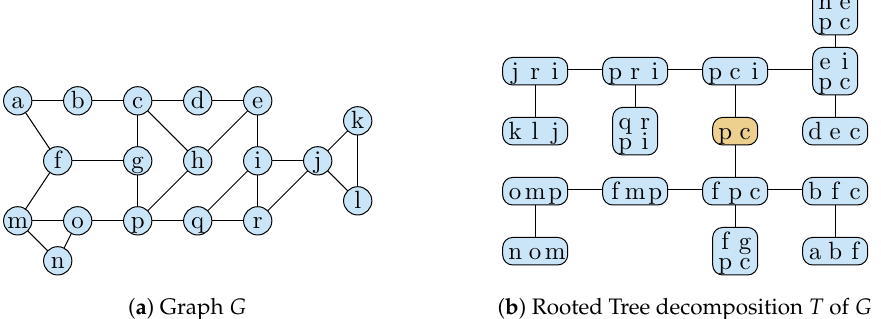
Figure 1. Running Example with tree decomposition rooted at { p , c } .